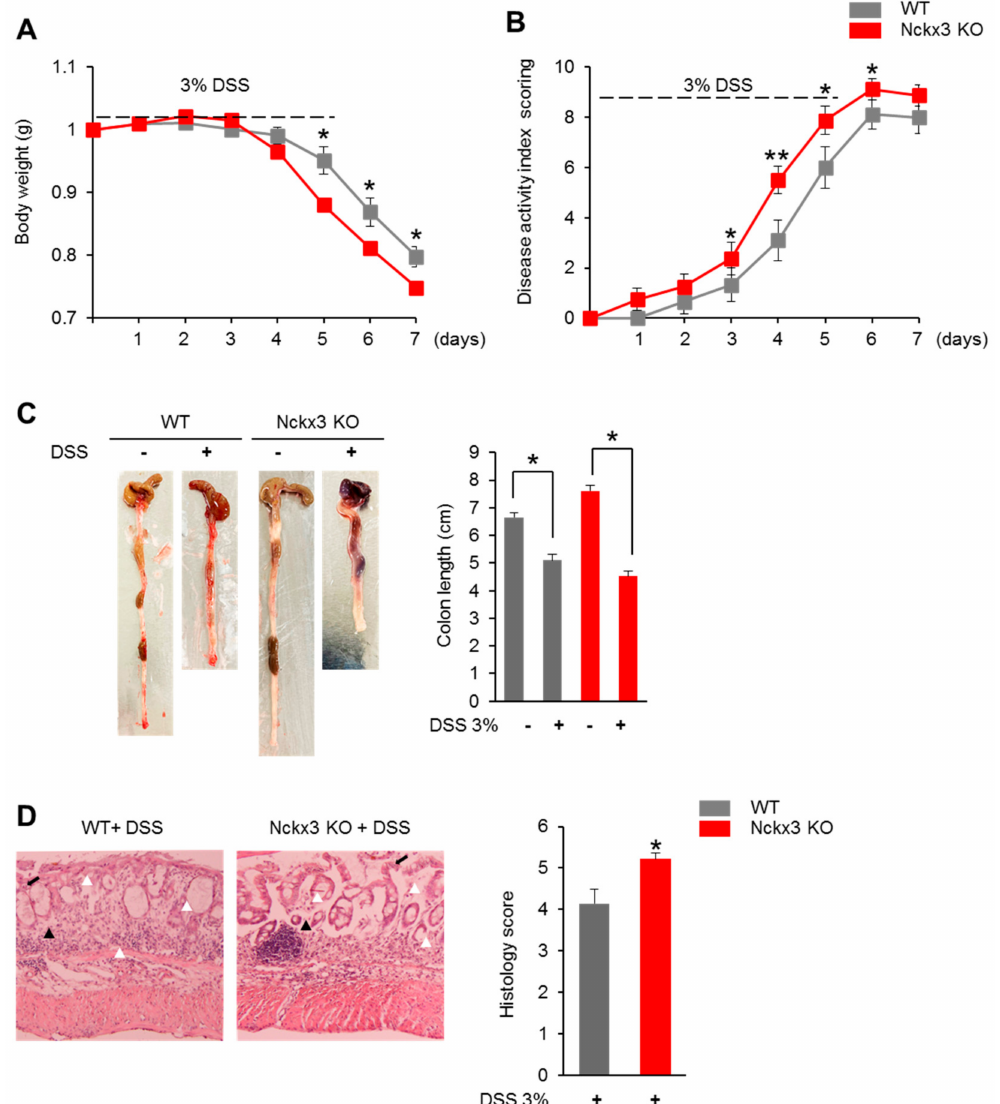
Figure 4. Nckx3 deficiency enhanced the severity of dextran sulfate sodium (DSS)-induced colitis. Colitis was induced in WT and Nckx3 KO mice by the administration of 3% DSS in the drinking water for 5 days followed by regular drinking water for an additional 2 days. Mice were evaluated daily for ( A ) weight loss and ( B ) disease activity index (DAI) scores were calculated. Colon length was also measured ( C ). Representative colon histological sections stained with hematoxylin and eosin (H&E) were shown at ( D ) days 7 after colitis induction (n = 10 per group). Images were shown at original magnification 10X. Histological sections were blindly scored on a scale of 0 to 6 to generate a histological score and individual mouse scores were shown with each data point representing a single mouse. Arrow indicates the ulceration; white arrowhead: neurotrophil; black arrowhead: polyps. The combined histopathologic score ranged from 0 to 6. Nckx3 KO + DSS group exhibited higher in the histological scoring for inflammatory infiltrates and epithelial damage than in the WT group. Data represent the mean ± SEM. Statistical significance was determined by two-way ANOVA, * p < 0.05 WT +DSS vs. Nckx3 KO +